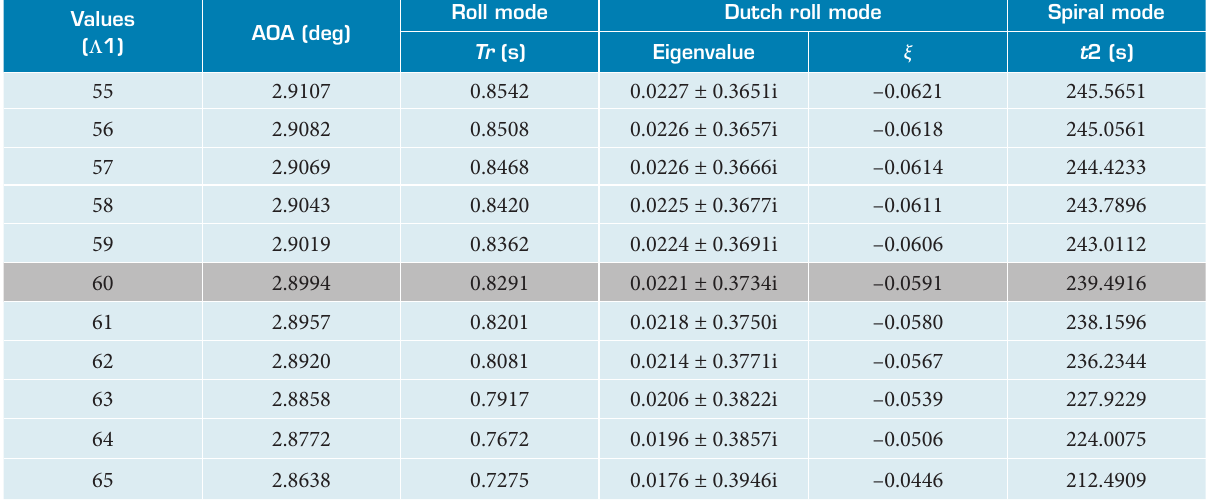
Table 4. Influence of Λ 1 on lateral-directional stability.